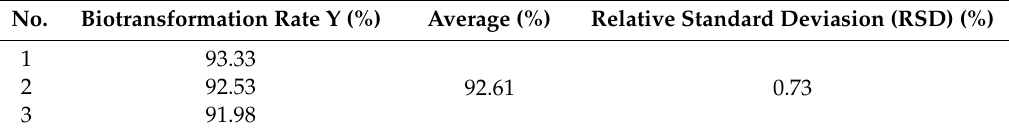
Table 5. Transforming rates of three parallel experiment and statistic analysis.